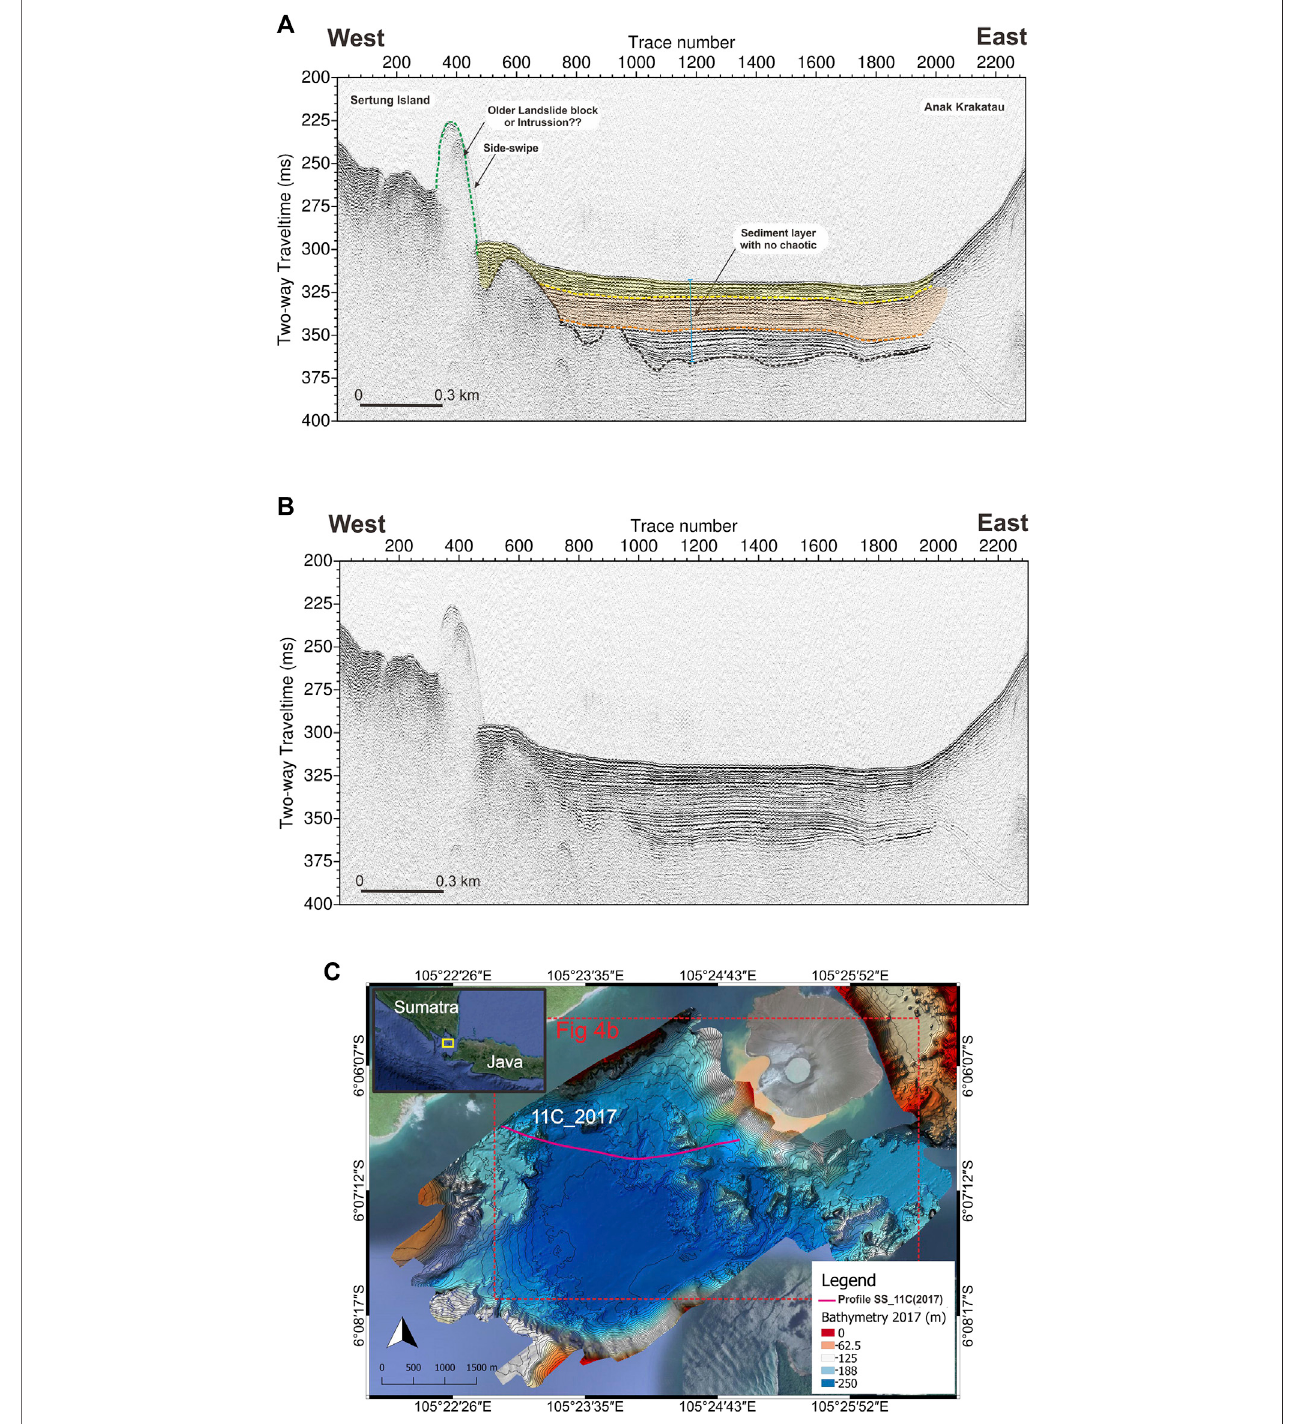
FIGURE 5 | Seismic Pro fi le SS_11C (2017 Data) with 3:1 exaggeration (The black striped line is basement, yellow striped line is consider as young deposit, meanwhile pink and sky light-brown striped line are older deposit). (A) Interpreted of the Seismic Pro fi le SS_11C. (B) Un interpreted of Seismic Pro fi le SS_11C. (C) The Seismic Pro fi le SS_11C location.